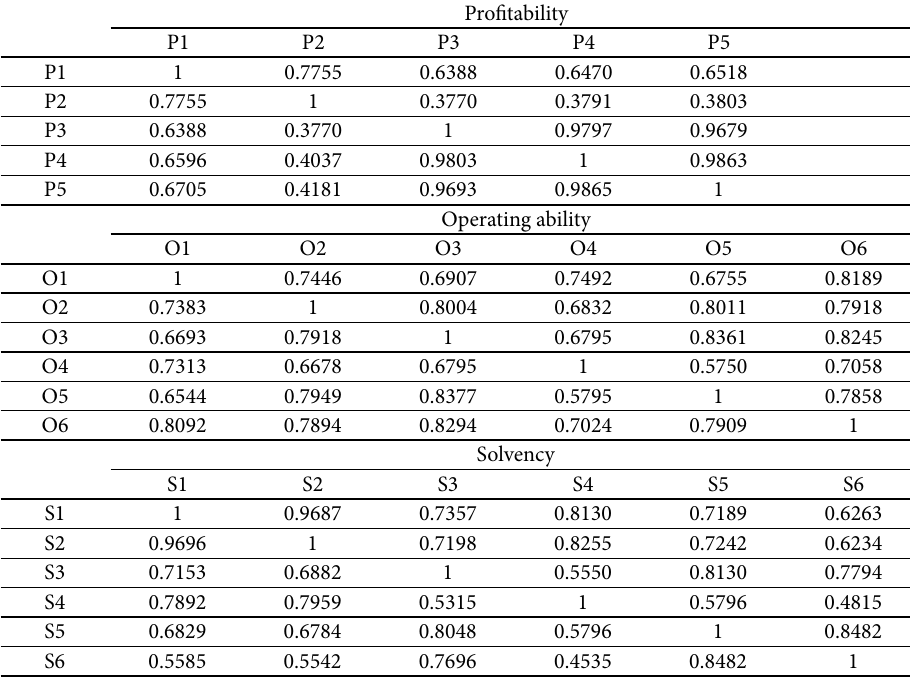
Table 6. The grey correlation matrix on three